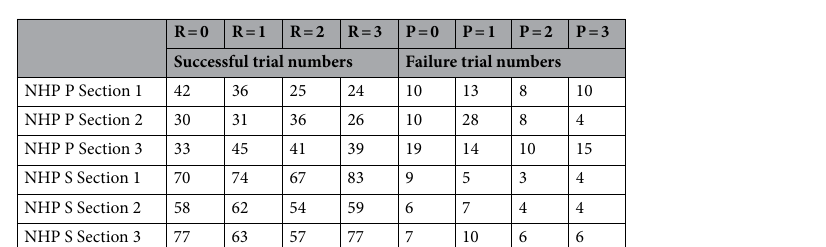
Figure 7. ( a ) Task period distribution of significant units from two NHPs for three sensorimotor brain regions (PMd, M1, S1) fit to each unit’s best model. ( b ) Post-cue reward and punishment encoding distributions of significant units using the units’ best model (see methods and text). ( c ) Same as ( b ), for the post-feedback period.